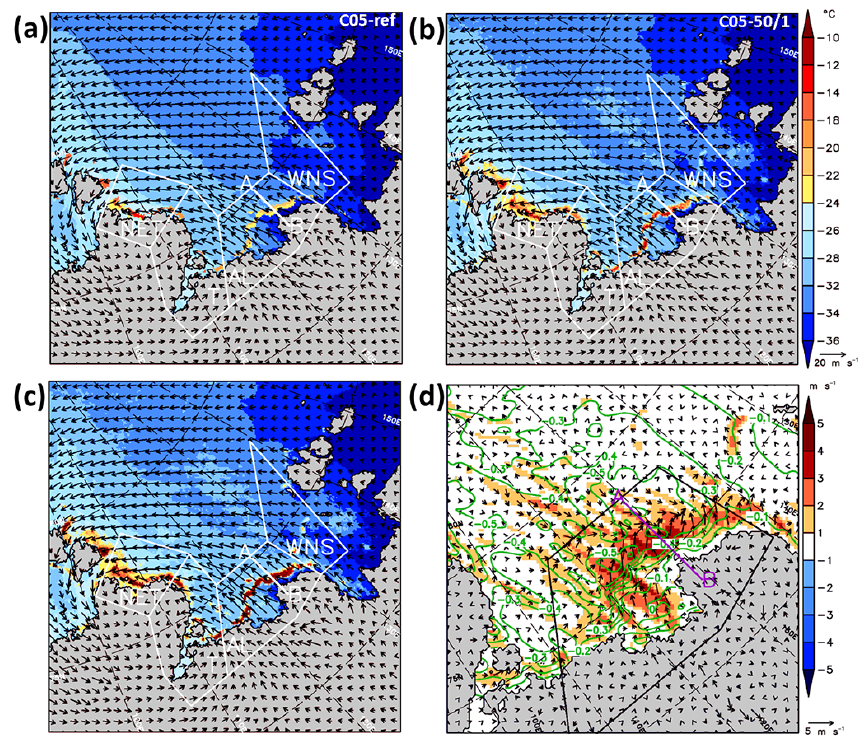
Figure 6. Surface temperature and 10m wind field on 4 January 2008 at 15:00UTC in (a) C05-ref (reference), (b) C05-50/1 (realistic), and (c) C05-10/0 (open water). In (d) anomalies (C05-10/0 minus C05-ref) over the AL polynya are shown for wind vectors (note different scale) and wind magnitude (colour shaded) at 10m height and for pressure at mean sea level (green contour lines). The white line in (a) to (c) (magenta in d ) marks the cross section A → B used for Fig.